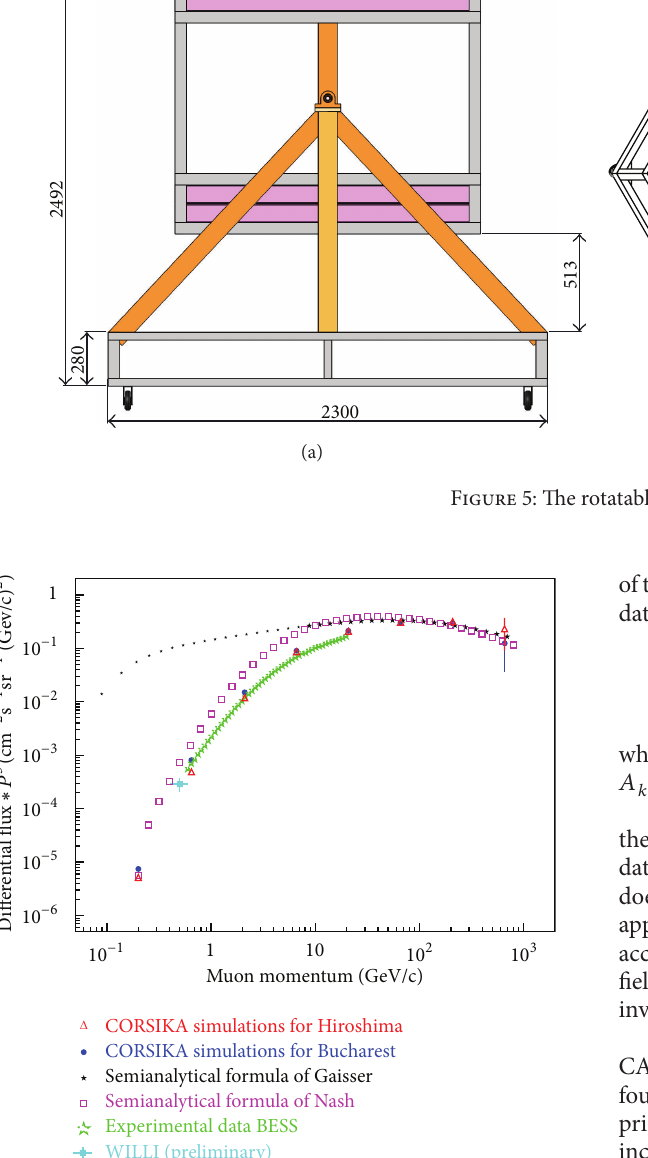
azimuthal angle of the muons ( 0 ∘ for vertical). The parameters 𝐴 𝜋,𝑘 are the normalizations of the pion and kaon